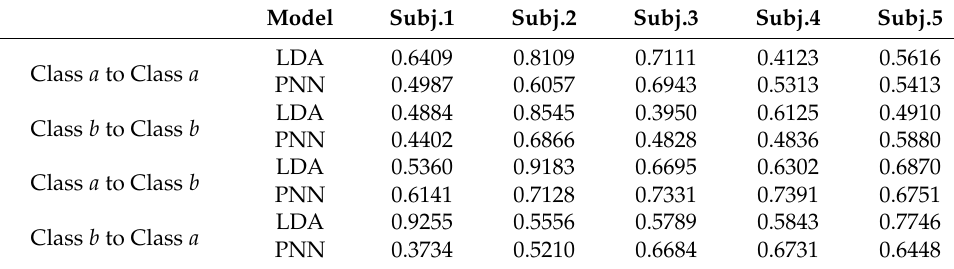
Table 3. Correlation analysis on each subject for the influence of muscle fatigue.